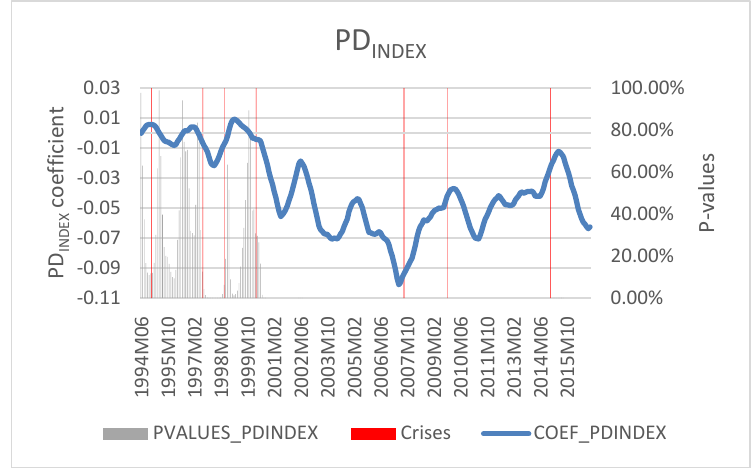
Figure 4. Coefficients and p -values for the PD INDEX variable of the rolling regression. Details of p -values are available in Appendix C. Source: Authors’ work.